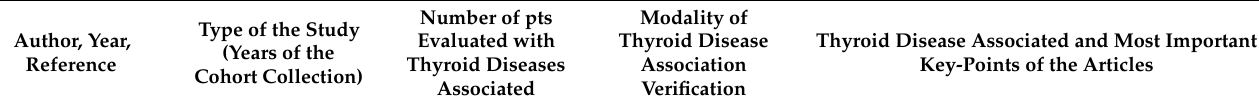
Table 4. Comparison of our series with clinical series that were published after